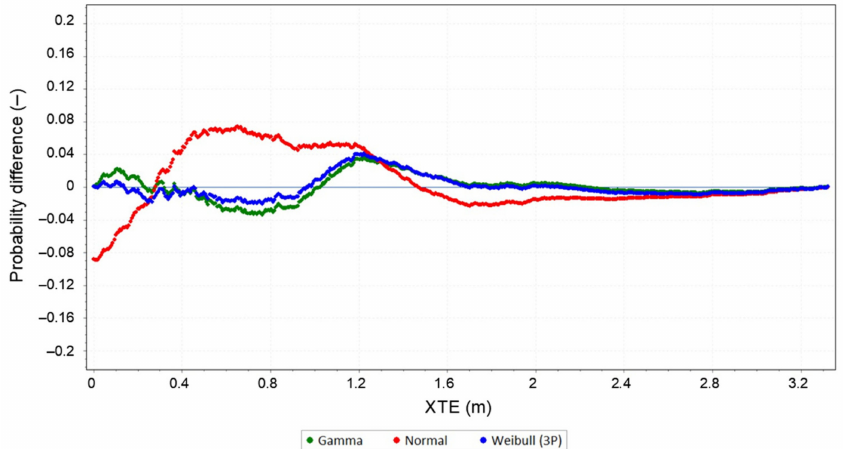
Figure 5. The differences between the probabilities of the XTE variable occurrence for the empirical and theoretical gamma (green colour), Weibull (3P) (blue colour) and normal (red colour)